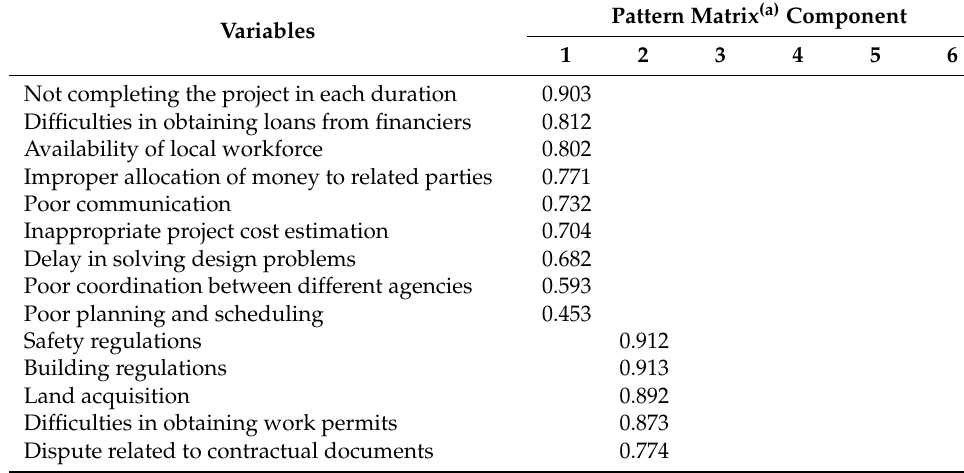
Table 5. Pattern matrix (a)